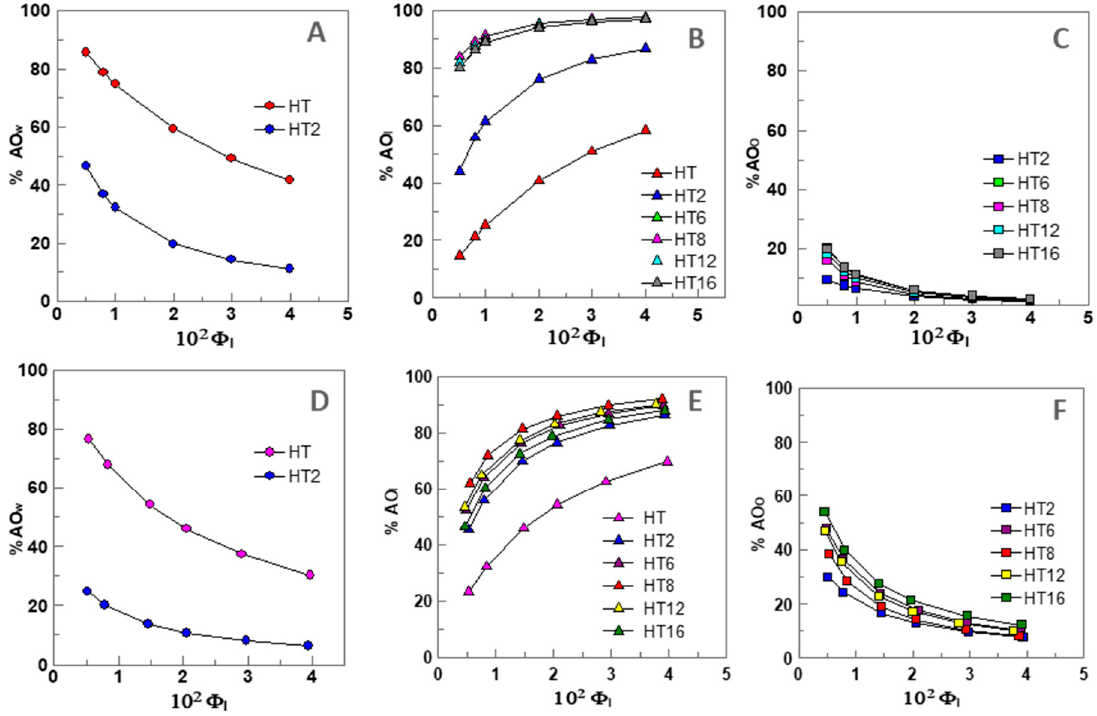
Figure 2. Variation of the percentages (%AO) of HT and its derivatives in the different regions (W—water, I—Interface, O—oil) of 1:9 (O / W) nanoemulsions (( A – C ), [AO T ] = 0.125 mM) and 4:6 (O / W) emulsions (( D – F ), [AO T ] = 0.500 mM) composed of fish oil / 0.04 M citrate buffer, pH = 3.65 / Tween 80, T = 25 ◦